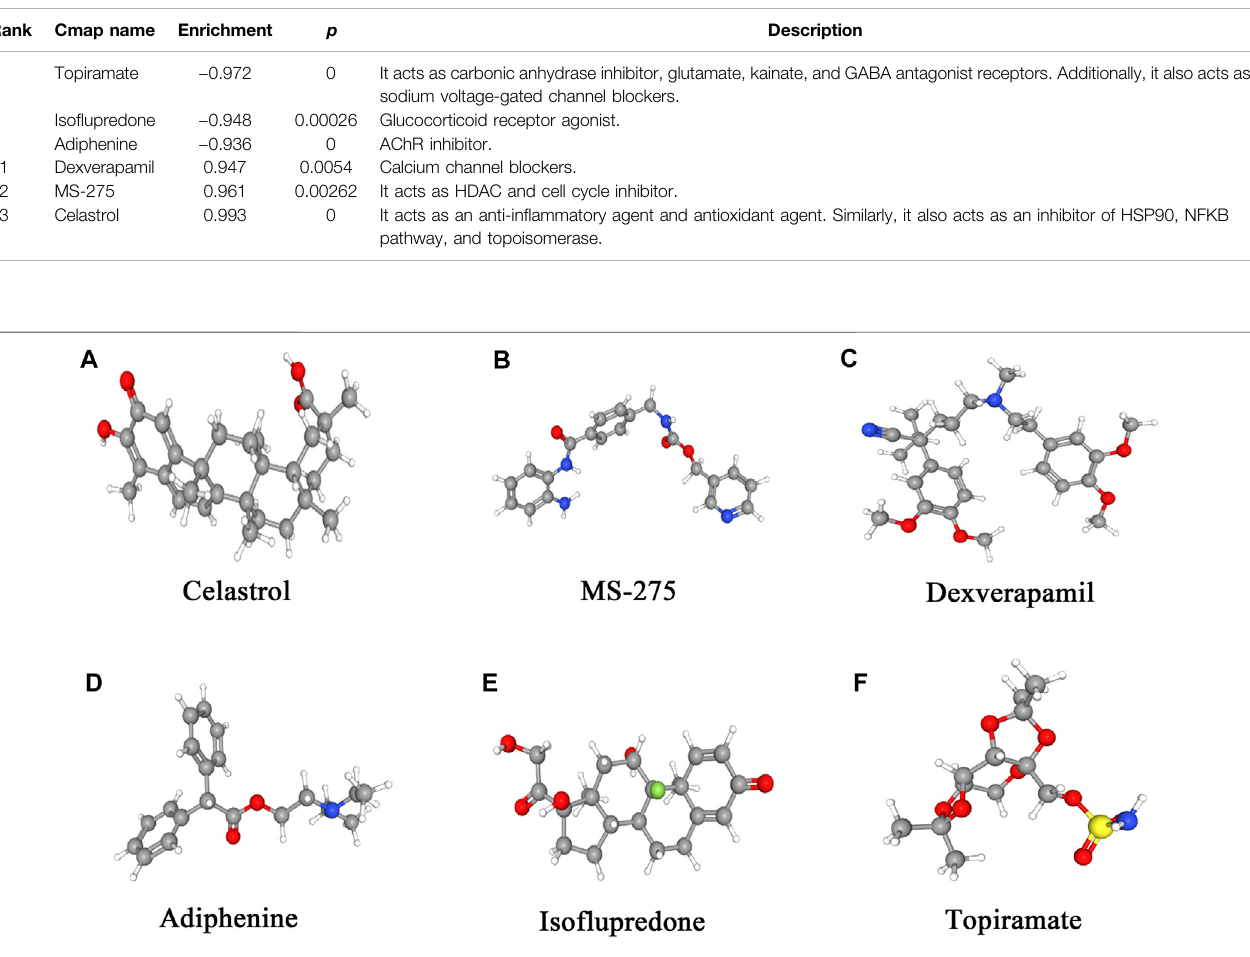
Frontiers in Molecular Biosciences |